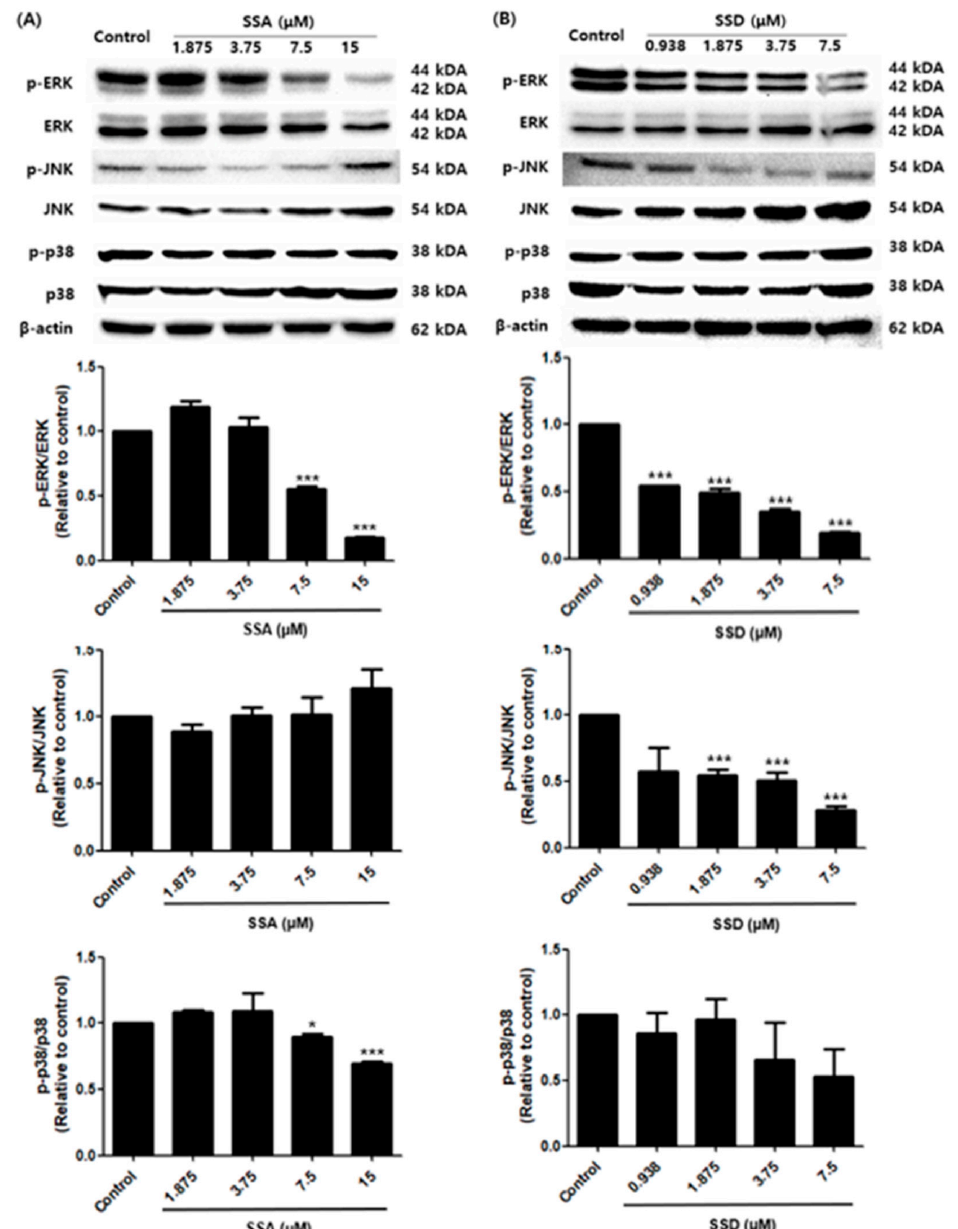
Figure 7. Effect of SSA ( A ) and SSD ( B ) on adipogenesis is mediated by MAPK signaling pathway as examined by Western blot analysis. The relative intensity of each band of the phosphorylated ERK, JNK, and p38 after normalization for the levels in the total forms is shown, and β -actin was used as a loading control. Results are shown as a relative of control (0.5% DMSO) values for this experiment. Data are mean ± standard error of the mean (SEM) of three independent experiments. * p < 0.05, *** p < 0.001, compared with control, *: decreased compared to